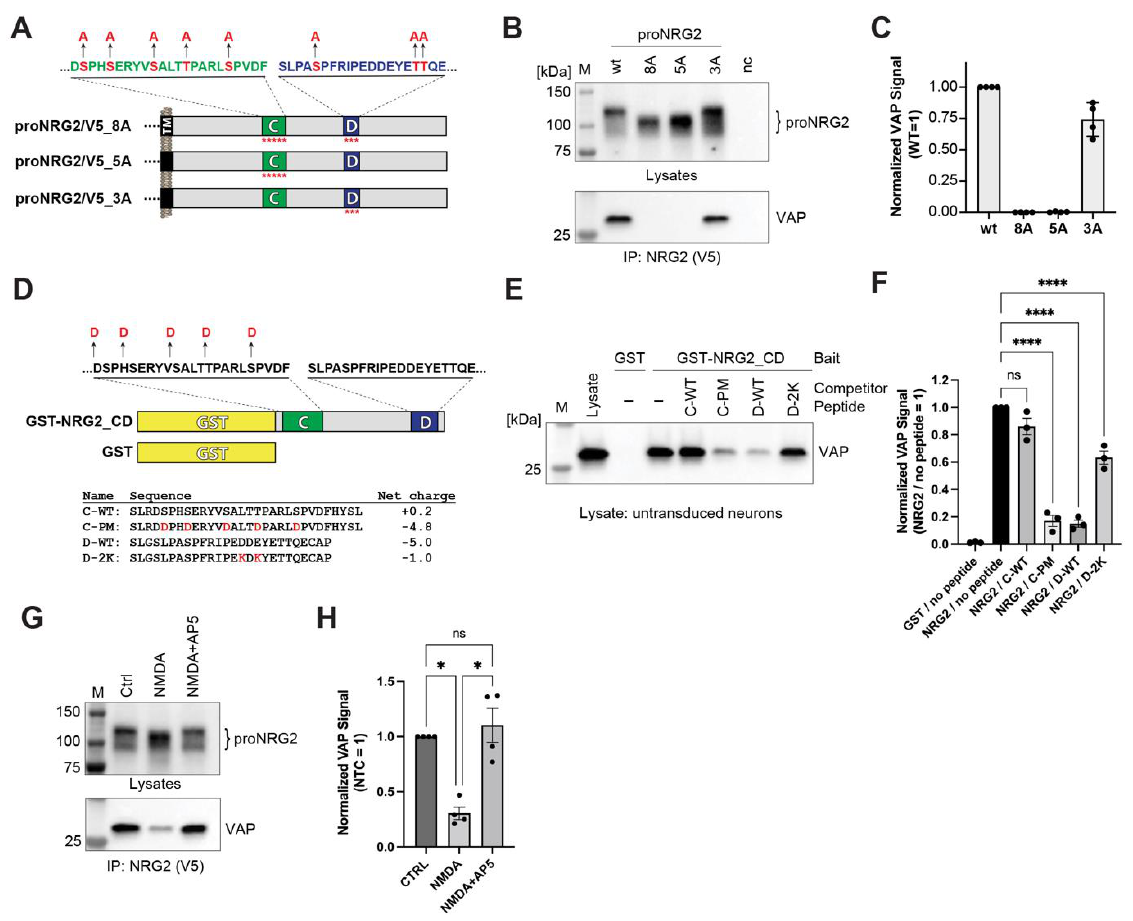
Figure 5. The proNRG2 C-box harbors a phosphorylation-dependent VAP binding site, and VAP binding is regulated by NMDA receptor activity. ( A ), Schematic illustration of WT and point-mutated C- and D-box sequences in the proNRG2 ICD, with targeted putative Ser/Thr phosphorylation sites indicated. ( B ), Representative co-immunoprecipitation Western blot of AAV-transduced neurons showing proNRG2 signals in cell lysates above and VAP co-immunoprecipitation signals below. The blot illustrates how rendering Ser/Thr residues in the C-box (proNRG2_8A and 5A), but not the D-box (proNRG2_3A), nonphosphorylatable affects proNRG2 electrophoretic mobility and abolishes VAP co-immunoprecipitation. ( C ), Densitometric analysis of VAP co-immunoprecipitation signals. Data are normalized to WT proNRG2 and represent the mean ± SD ( n = four independent experiments). ( D ), Schematic illustration of GST-NRG2_CD and GST-only negative control bait proteins used in pulldown experiments. Ser/Thr -> Asp substitutions in the C-box are indicated above, and the sequences as well as the net charges of competing C- and D-box peptides are shown below (mutated residues highlighted in red). ( E ), Representative Western blot showing VAP signals after pulldown from untransduced neuron lysates with GST or GST-NRG2_CD bait proteins, either in the absence or presence of competing peptides, as indicated. Note that only the phospho-mimicking C-box peptide C-PM and the WT D-box peptide successfully compete for VAP binding, whereas neither C-WT nor D-2K peptides compete. ( F ), Summary analysis of representative results shown in ( E ). Data are plotted as normalized VAP signal intensities (NRG2/no peptide = 1) and represent the mean ± SEM ( n = three independent experiments). ( G ), NMDA receptor stimulation (NMDA; 50 µ M) increases crNRG2 electrophoretic mobility indicative of dephosphorylation (top) and decreases VAP signals in the corresponding immunoprecipitation samples (bottom). ( H ), Summary analysis of representative results shown in ( G ). Data are plotted as normalized VAP signal intensities (Ctrl = 1) and represent the mean ± SEM ( n = four independent experiments). *, p < 0.05; ****, p < 0.0001 (one-way ANOVA).